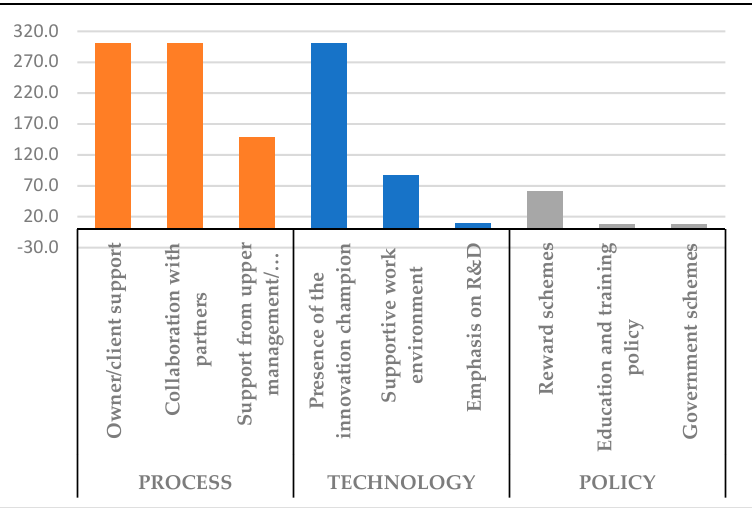
Figure 6. Top three BIM innovation enablers in developing countries. Table 10. Scores and ranks of BIM innovation enablers in developing countries.